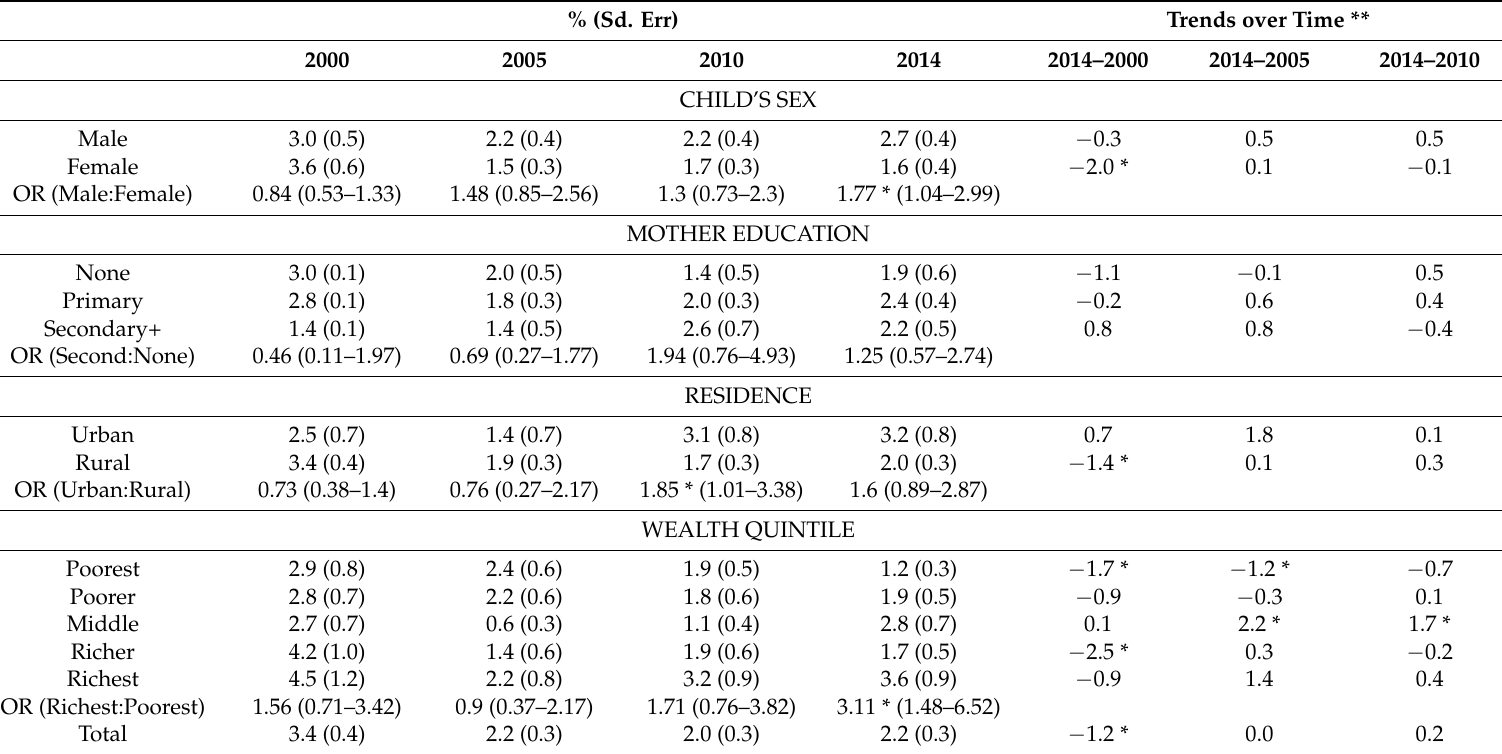
Table 5. Prevalence of overweight in children in the four surveys according to their social